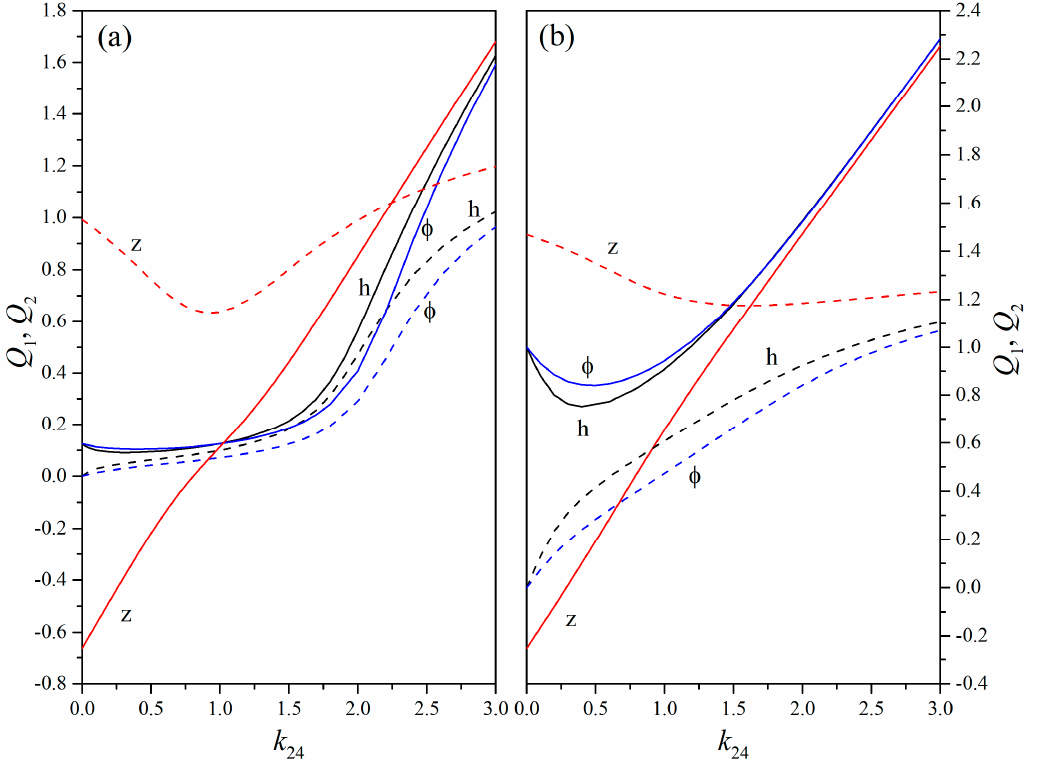
Figure 3. Dependence of Q 1 (solid lines) and Q 2 (dashed lines) on k 24 for Q = 0.125 ( a ) and Q = 1 ( b ) and di ff erent types of anchoring, labelled by homeotropic (“h”), azimuthal (“ φ ”) and zenithal (“z”). w = 1.